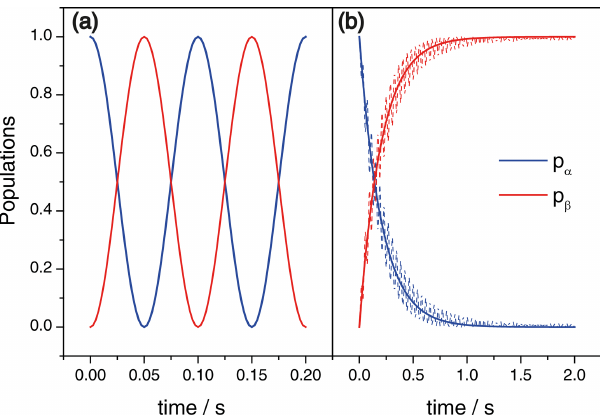
Figure 2. (a) Time dependence of the state populations in the case of coherent exchange with ω x (cid:14) 2 π = 10Hz, as obtained from Eq. (7). (b) Populations after a passage through zero field, ω z = 0, as functions of the switching time τ sw . Here the solid lines present the result of Eq. (8) and the dashed lines show the numerical simu- lation result. Here ω x (cid:14) 2 π = 10Hz, ω max z (cid:14) 2 π = 100Hz. Initially the system is in the | α (cid:105) state; the blue and red lines shown the pop- ulations of the | α (cid:105) and | β (cid:105) states,